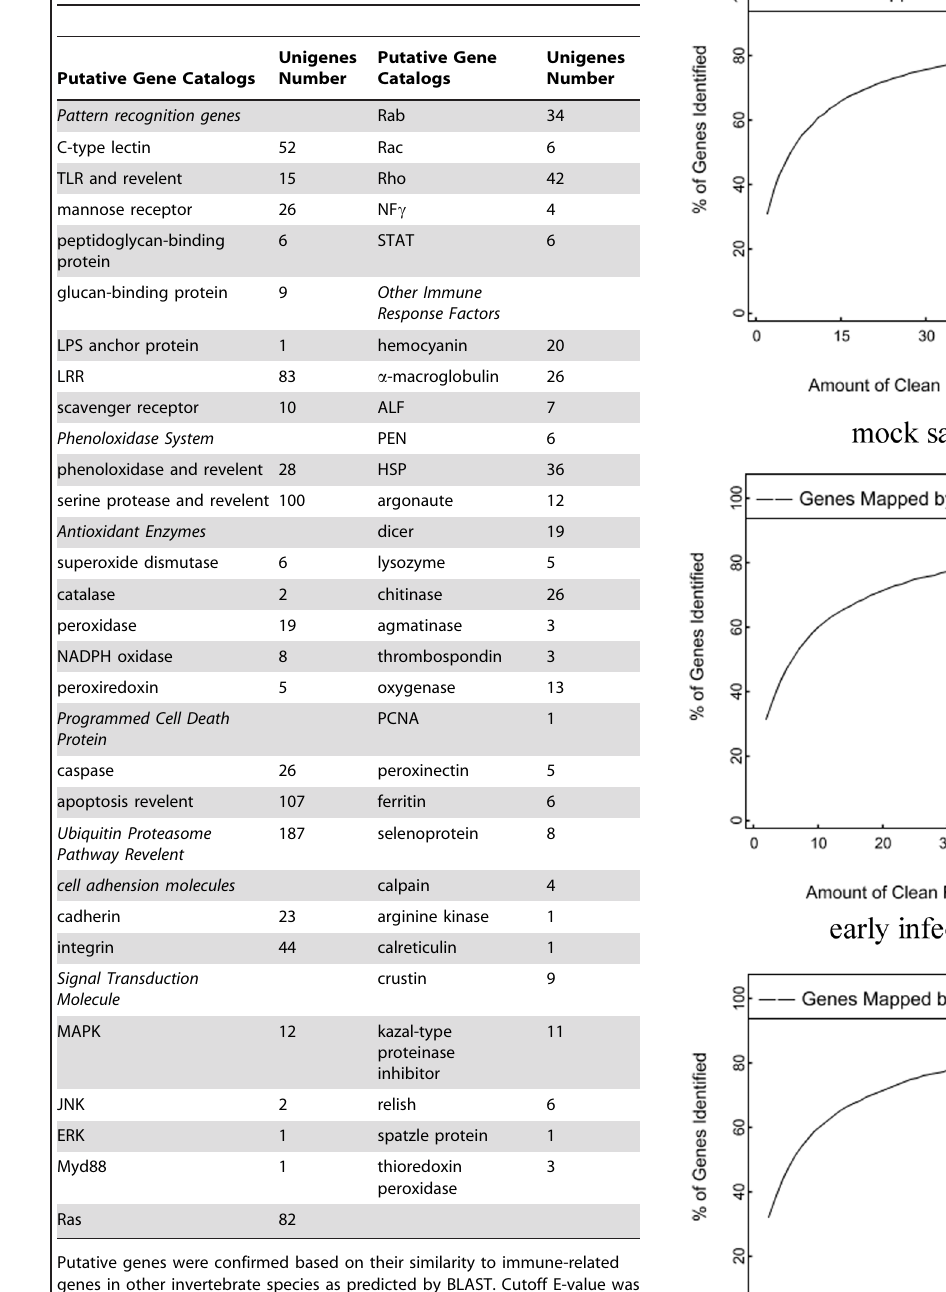
Putative Gene Catalogs